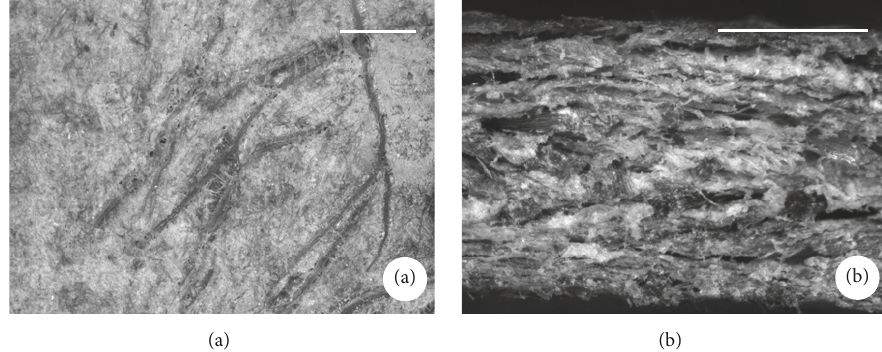
Figure 7: Optical microscope images of the composite consisting of 25% cotton :75% OOW/AF: (a) surface view of panel and (b) side view of panel. Bar = 0.5 mm.